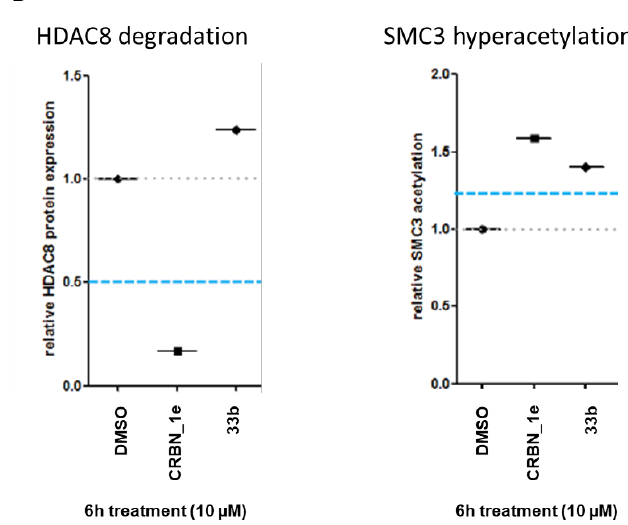
Figure 6. ( A ) SK-N-BE(2)-C neuroblastoma cells were treated for indicated time points with 10 µ M of PROTACs. Degradation of HDAC8 and acetylation of HDAC8 target was analyzed via Western blot. ( B ) SK-N-BE(2)-C neuroblastoma cells were treated for 6 h with indicated concentrations of as well as total HDAC8 levels, were assessed by Western blot. Quantified ac-SMC3 or ac-tubulin expression, respectively, was normalized to the respective tubulin loading control and to the solvent control (DMSO). This quantification is reflected by the numbers below each blot. ( C )